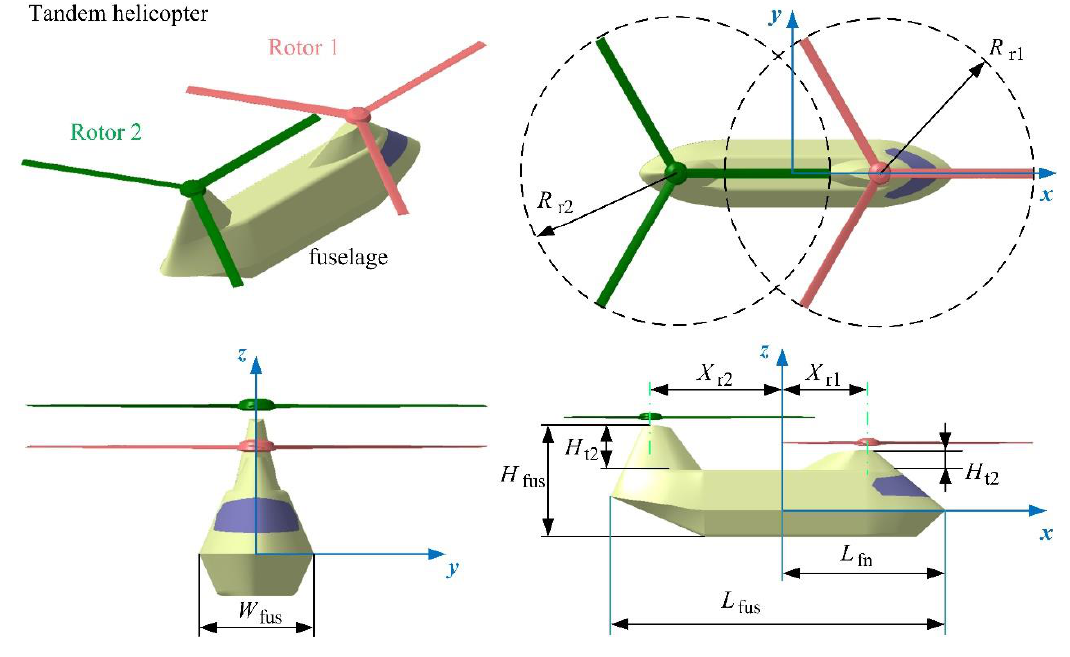
Figure 3. Tandem helicopter model and its size distribution. Table 1. The main dimensions of the helicopter model.